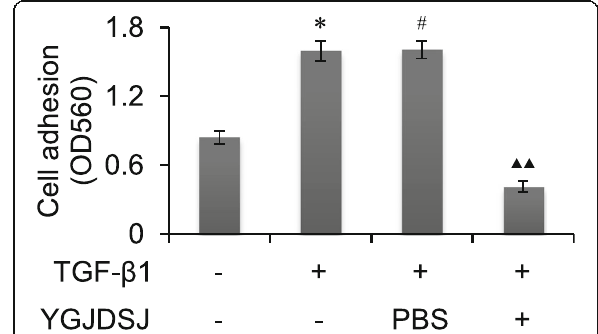
Fig. 5 Effects of YGJDSJ on TGF- β 1-induced cell adhesion. Bel-7402 cells were treated with TGF- β 1 and YGJDSJ or PBS for 48 h, and subjected to cell adhesion assay using a commercial kit according to the manufacturer ’ s manual. * p < 0.01, versus control group; # p > 0.05, versus TGF- β 1 group; ▲▲ p < 0.01, versus PBS group